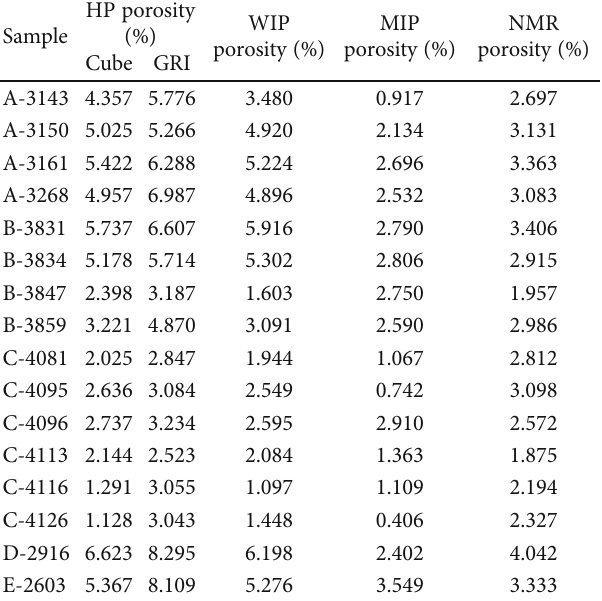
Table 3: Results of e ff ective porosity from four methods.